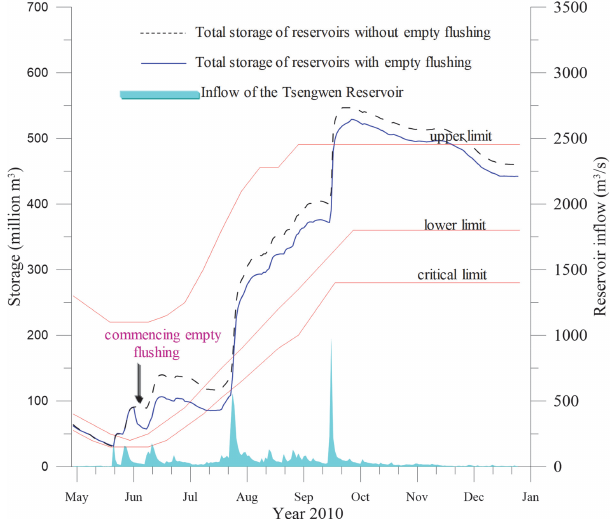
Figure 11. Reservoir inflow and storage throughout 2010.